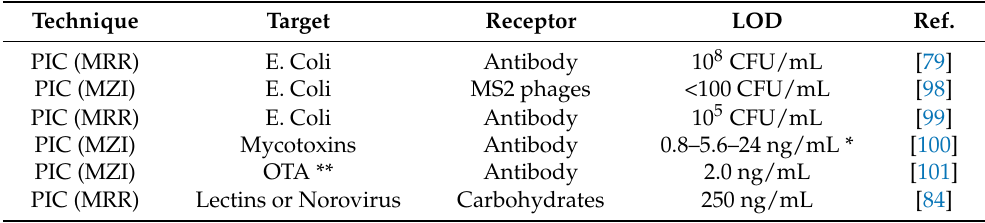
Table 2. Overview of different analytes detected with PIC technology (MRR = Micro-ring Resonator, MZI = Mach–Zehnder interferometer, YI = Young interferometer, PhCWS = photonic crystal waveguide sensor, OTA = ochratoxin A, CEA = carcino-embryonic antigen, DNA = deoxyribonucleic acid, ssDNA = single-stranded DNA, HSV-1 = herpes simplex virus 1, HPV = human papilloma virus, LAM =